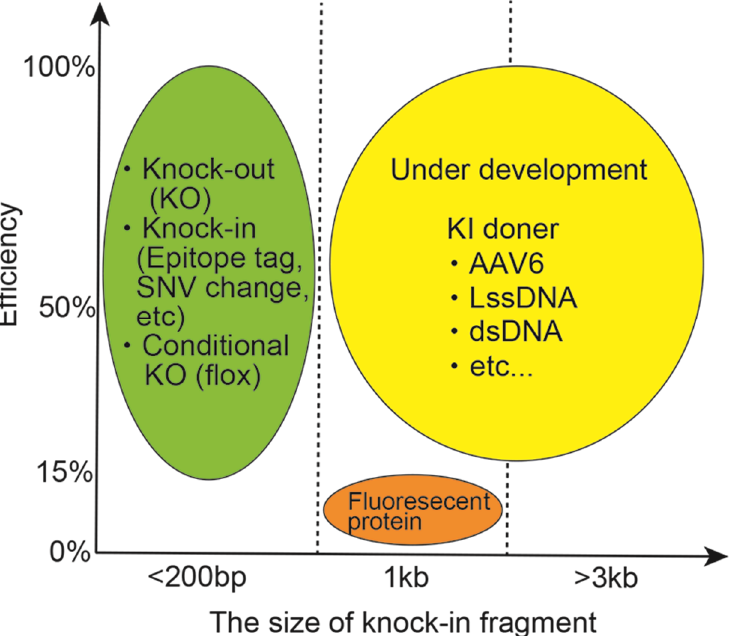
Figure 5. The i -GONAD efficiency for knock-out (KO), knock-in, and conditional KO. Sematic representation of genome editing efficiency and the size of knock-in fragment.